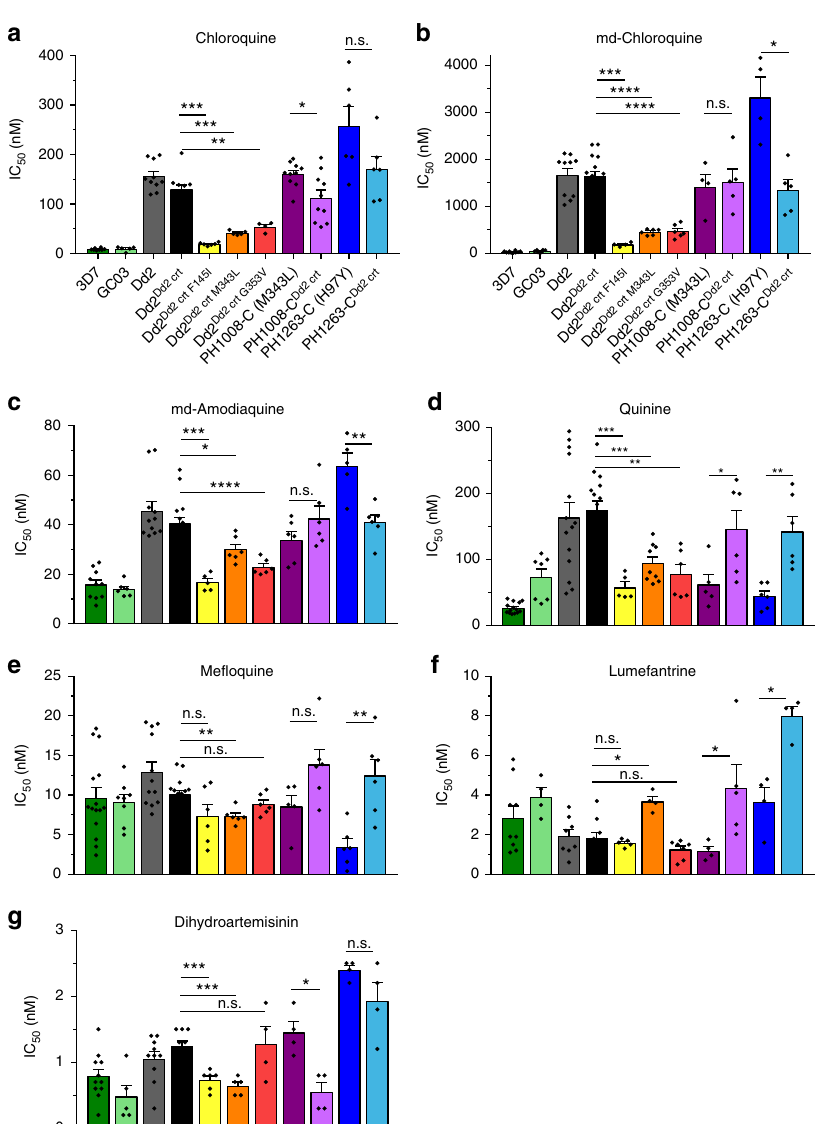
Fig. 4 Emerging PfCRT mutations modify P . falciparum susceptibility to multiple antimalarial drugs. Mean ± SEM IC 50 values (Supplementary Tables 7 – 10) were calculated from 72-h dose – response assays for drugs designated in a – g . N , n = 4 + , 2. Signi fi cance was determined using Mann – Whitney U tests comparing pfcrt -edited parasites and their isogenic controls. * p < 0.05; ** p < 0.01; *** p < 0.001; **** p < 0.0001; n.s. not signi fi cant,